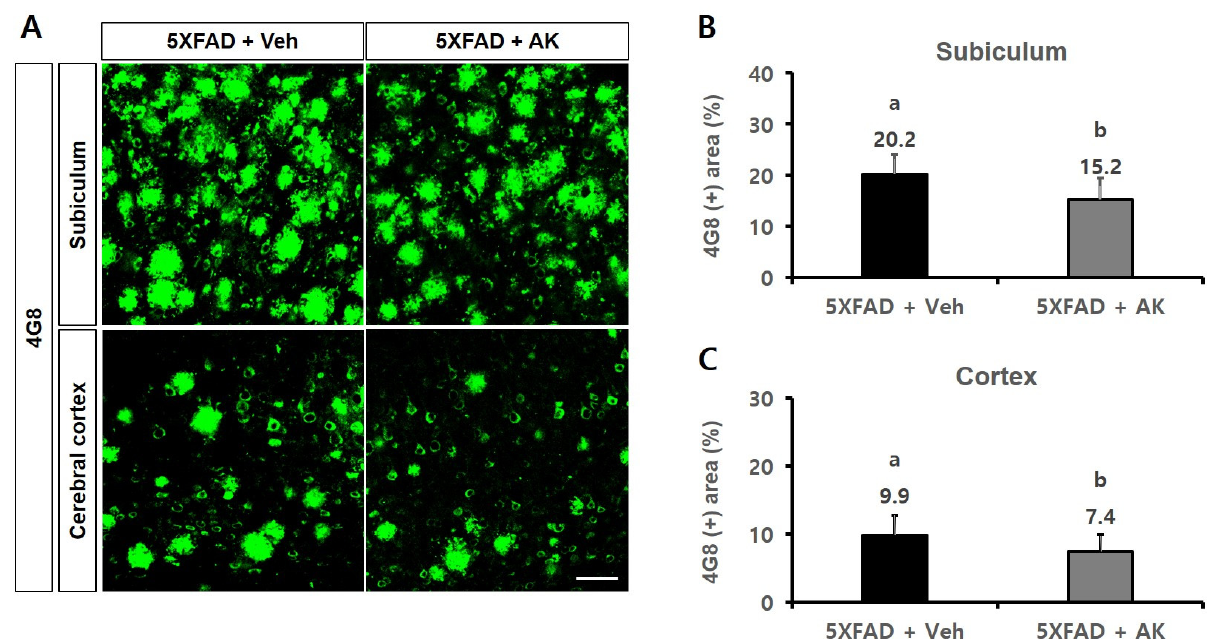
Figure 11. Inhibitory effects of AK extract on the β -amyloid accumulation in the subiculum and deep cortical layer in 5XFAD mice analysed by immunohistochemistry with 4G8 antibodies. ( A ) Photographs of amyloid plaques in brain parts dyed with 4G8 antibody; ( B ) Intensity of the 4G8 antibody-positive area in the subiculum; Scale bar = 50 µ m. ( C ) Intensity of the 4G8 antibody-positive area in the cortex. 5XFAD +Veh: control group and 5XFAD + AK extract: AK extract group ( n = 5). AK extract 200 mg/kg/day was orally administered for 21 days. Statistical analysis was performed using SAS software. The values marked by different letters were observed to differ significantly at p < 0.05 by Duncan’s multiple range test.